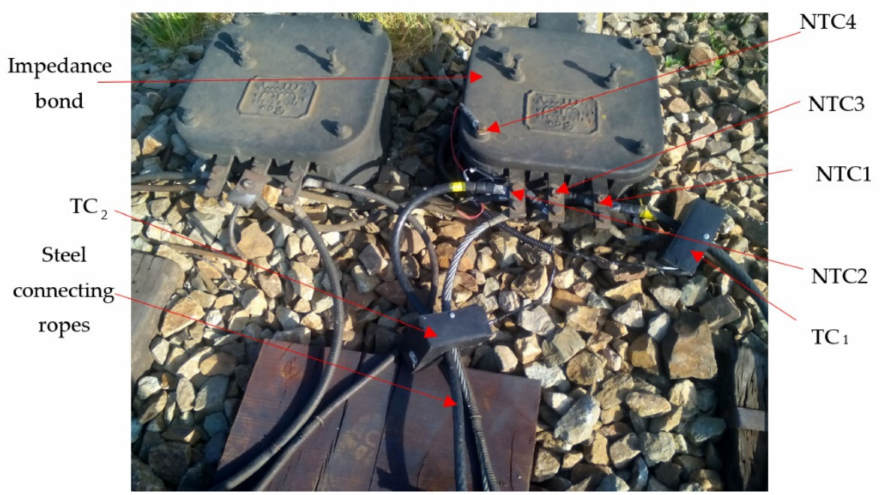
Figure 10. Image of the current and temperature transducers mounted in return circuit of oil impedance bond in the field.